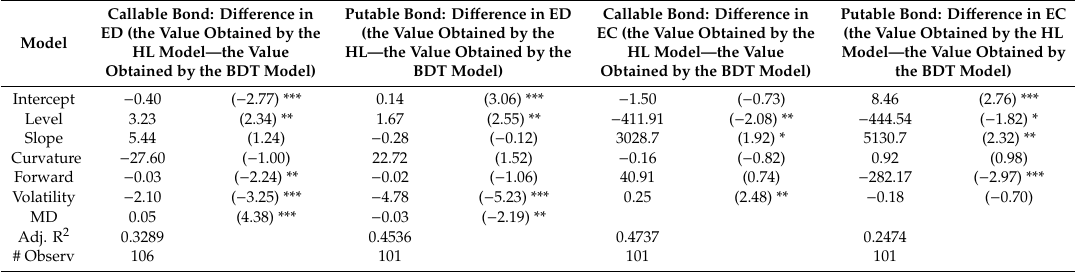
Table 3. Determinants of the di ff erences between the HL and BDT models in terms of ED and EC obtained for the parallel shift of the yield curve of ± 100